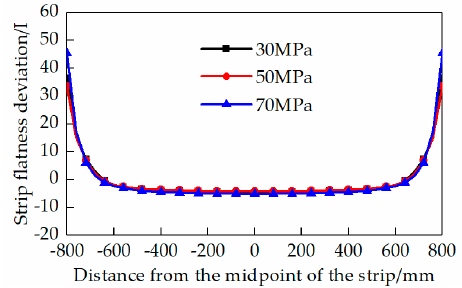
Figure 11. The effect of tensions on the flatness calculation deviation.